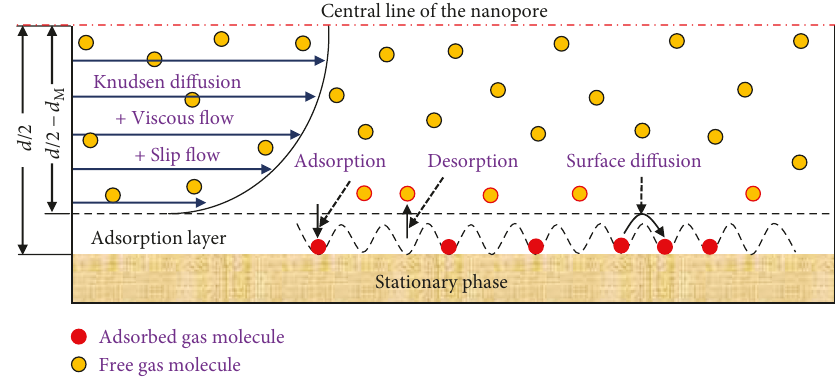
Figure 5: Three gas transport mechanisms in shale